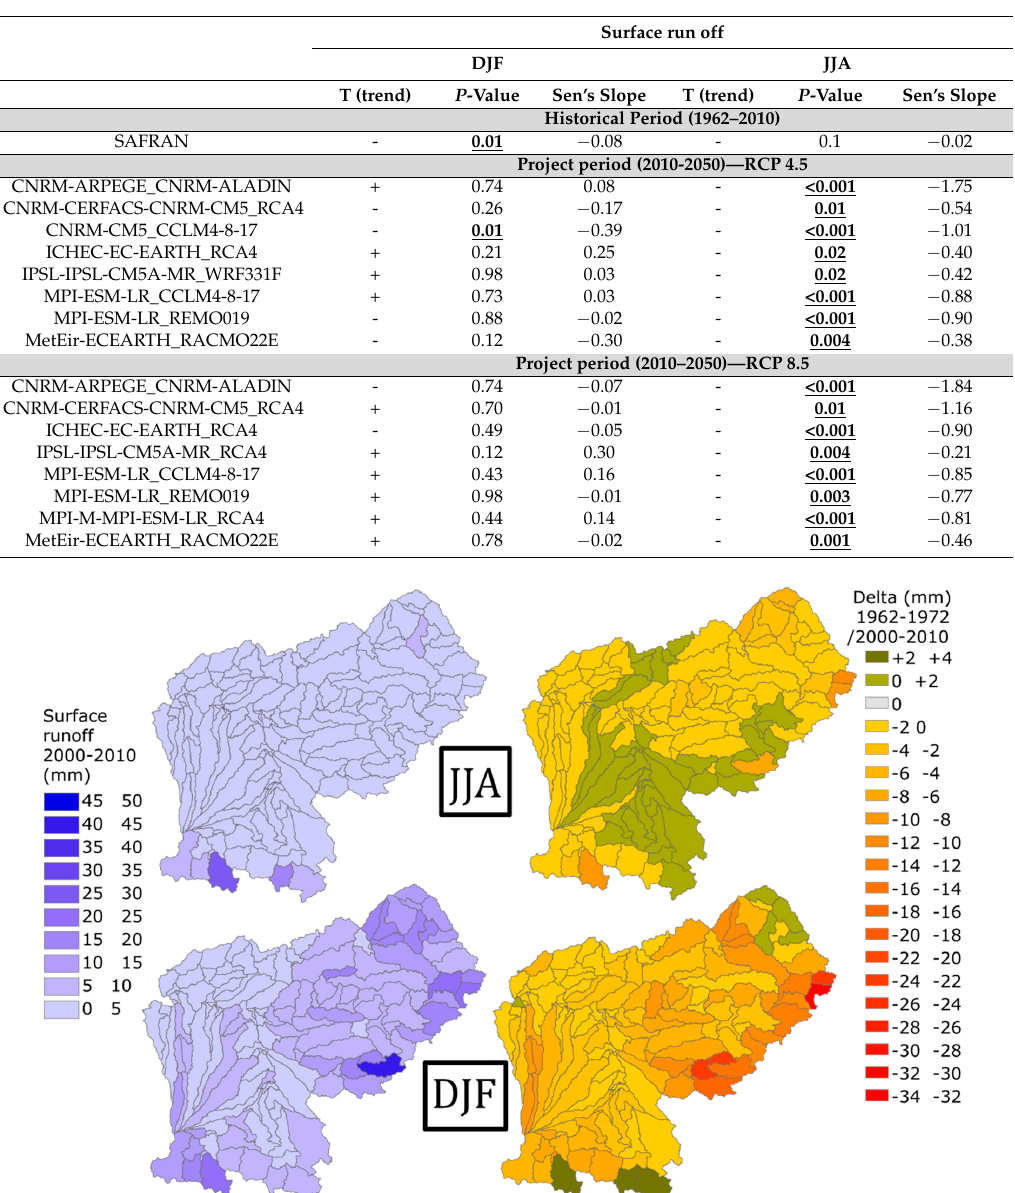
Table 8. Trend in surface run off over winter (DJF) and summer (JJA) seasons at watershed scale, for SAFRAN (historical period) and climatic ensemble (projected period). Bold numbers are significant trend considering α = 0.1 and underlined numbers considering α = 0.05.